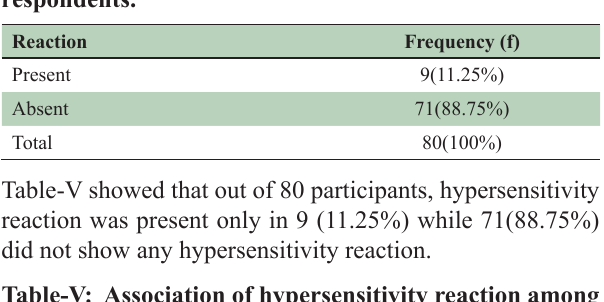
Table-V: Association of hypersensitivity reaction among factory workers and office workers.